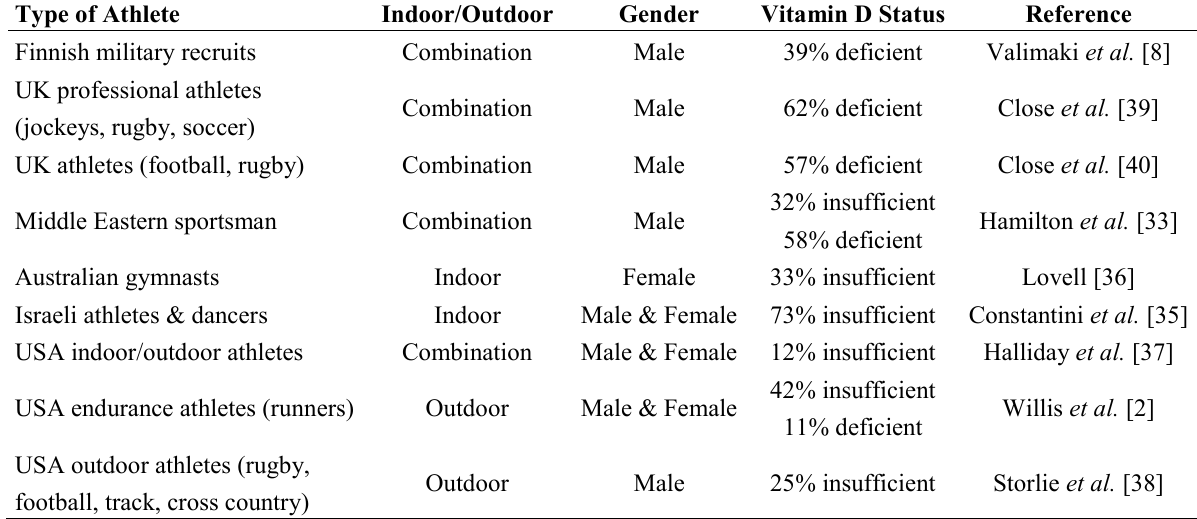
Table 2. Prevalence of Vitamin D deficiency (<20 ng/mL) and insufficiency (<32 ng/mL) in various athletic